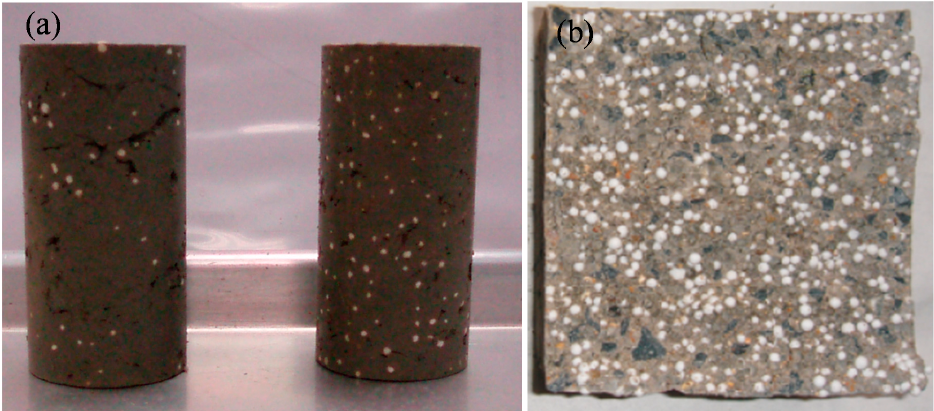
Figure 1. The lightweight bulk filling materials ( a ) lightweight clay [11]; ( b ) lightweight concrete